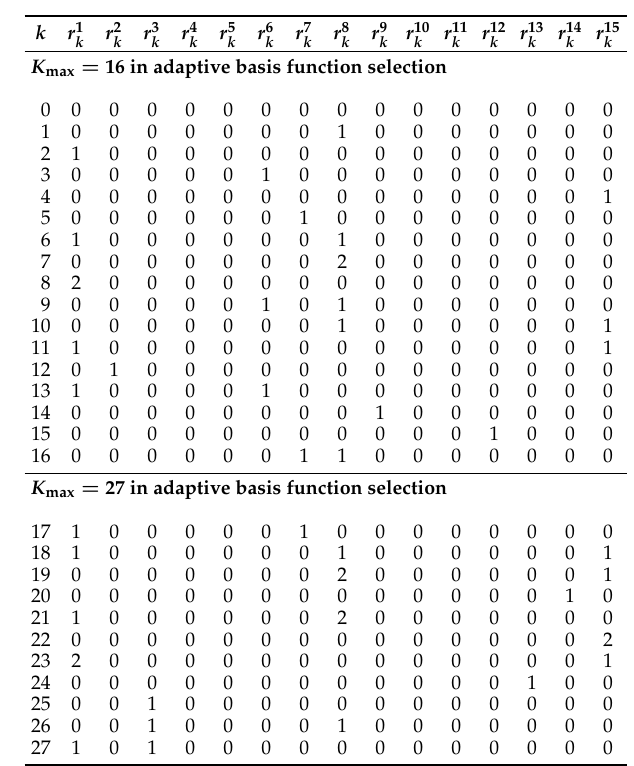
Table A33. Basis function sets of LC and LL proxy functions of BEL corresponding to K max derived by adaptive OLS selection.